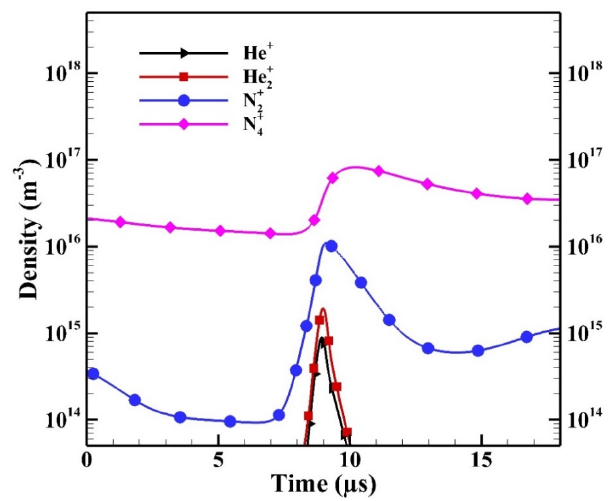
Figure 13. The spatial average densities of ion species during the breakdown in the positive half period (HP).